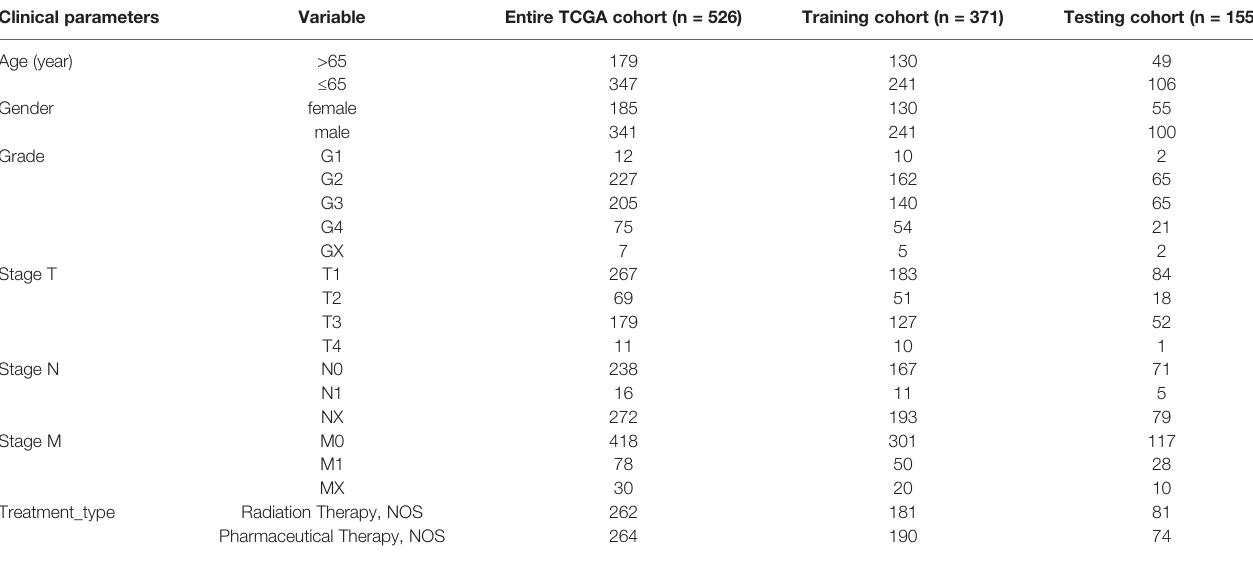
TABLE 1 | The clinical characteristics and associated cohorts of 526 ccRCC patients. Clinical